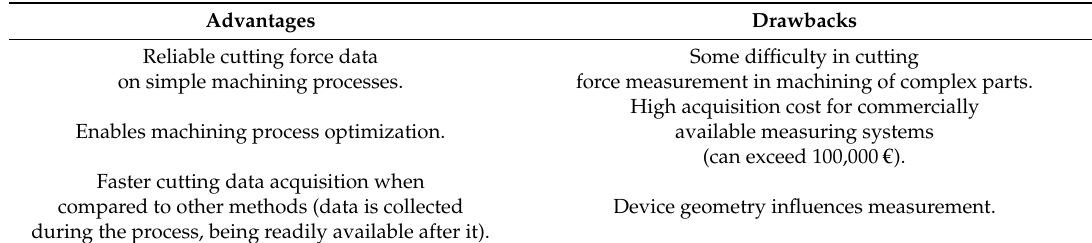
Table 5. Common advantages and drawbacks of force measurement